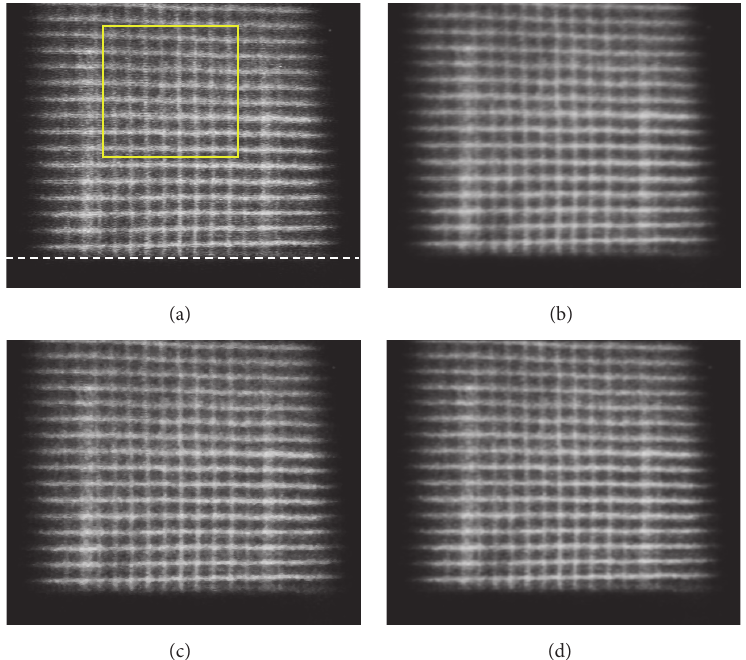
Figure 17: (a) Baseline delayed biacetyl MTV image without any filtering and (b) mean-filtered, (c) median-filtered, and (d) Gaussian filtered delayed image. The baseline image was taken at 107 CAD before TDC during compression stroke.